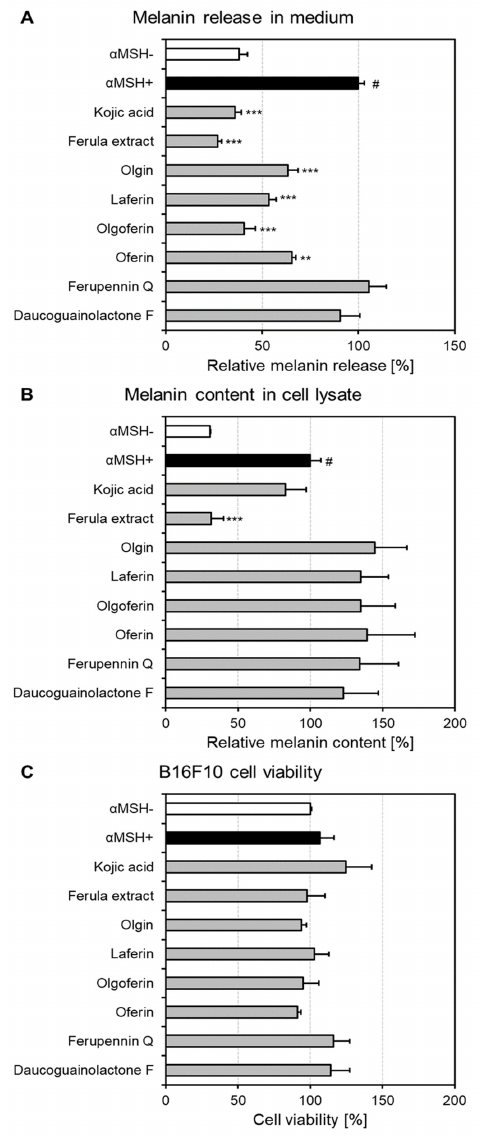
Figure 5. Influence of Ferula penninervis root extract and isolated sesquiterpene lactones on melanin release in conditioned medium ( A ), melanin content in cell lysate ( B ) and cell viability ( C ) in α -MSH-stimulated murine melanoma B16F10 cells. B16F10 cells were seeded in 6-well plates (0.5 × 10 5 /well) and treated with extract (100 µ g/mL) or sesquiterpene lactones (10 µ g/mL); melanin production was stimulated with α -MSH (10 nM). Kojic acid (100 µ g/mL) was used as positive control. After 72 h, the melanin release/content and cell viability were assessed. Data are expressed as the percentage of melanin release/content in comparison with α -MSH stimulated control cells ( α -MSH+) ( A , B ) or as percentage change in viability in comparison to the vehicle (DMSO) treated control group ( C ). Each point represents the mean ± S.E.M. of three independent experiments performed in triplicates; # p < 0.001 vs. non-stimulated control cells ( α MSH-); ** p < 0.01; *** p < 0.001 vs. α MSH+